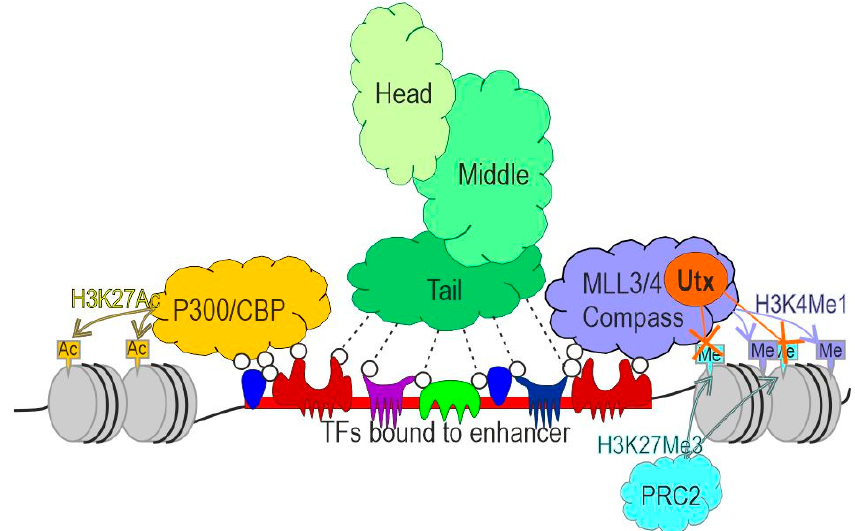
Figure 1. Schematic representation of the transcriptional complexes involved in enhancer activity. Various transcription factors (TFs) bind to enhancer sites and recruit complexes involved in transcription stimulation. p300/CBP possesses acetyltransferase activity and is responsible for H3K27 acetylation. The Mll3/4 complexes induce H3K4 monomethylation and recruit the UTX demethylase, which can remove the H3K27me3 generated by the PRC2 complex and associated with repressed chromatin. p300/CBP, Mll3/4, and UTX are thought to regulate transcription and enhancer activity through the modification of currently unknown components of transcriptional complexes on promoters. The subunits of the mediator complex form three main modules: head, middle, and tail. The mediator complex is recruited to the enhancer via multiple interactions between subunits of the tail module and the intrinsically disordered regions of TFs.